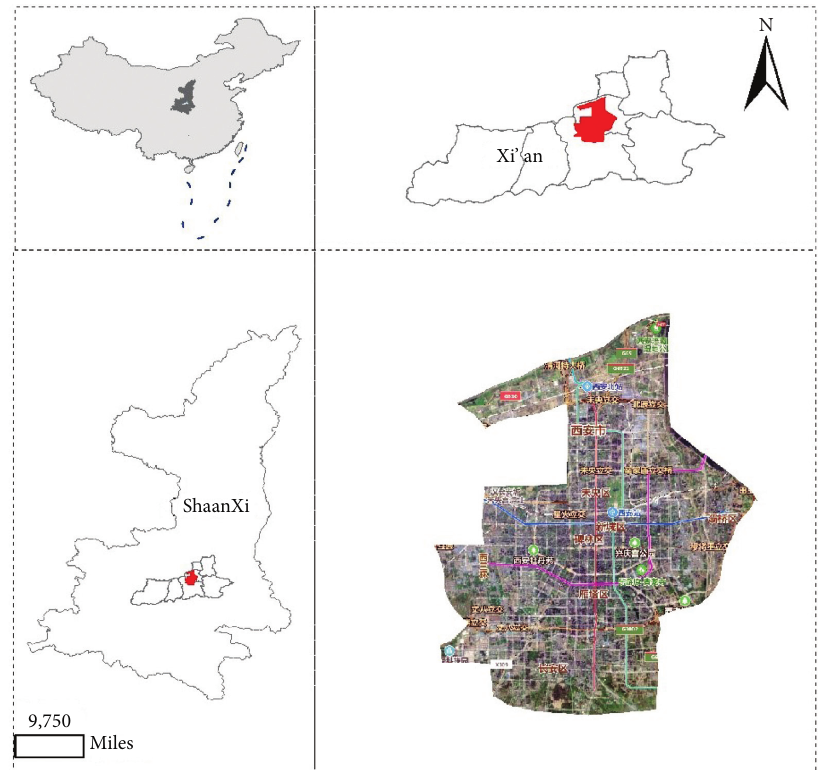
Figure 1: Schematic diagram of the study